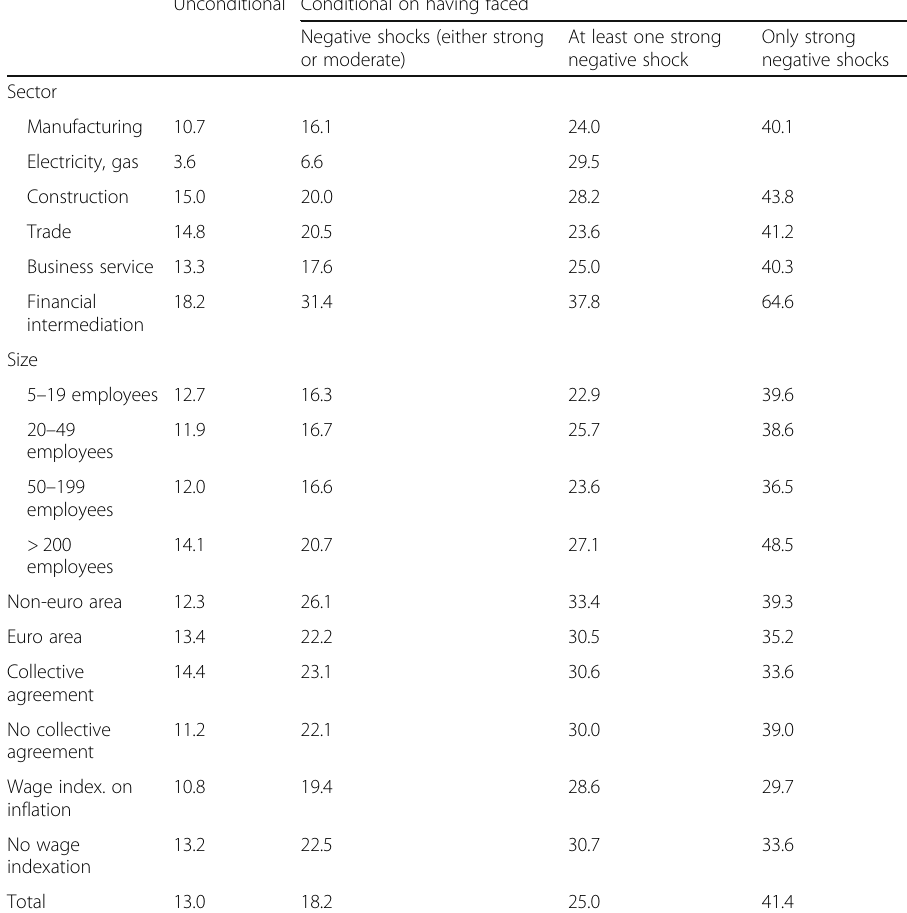
Table 3 Percentage of firms having cut non-base wage components in 2010 – 2013 by sector and size Unconditional Conditional on having faced Negative shocks (either strong or moderate)